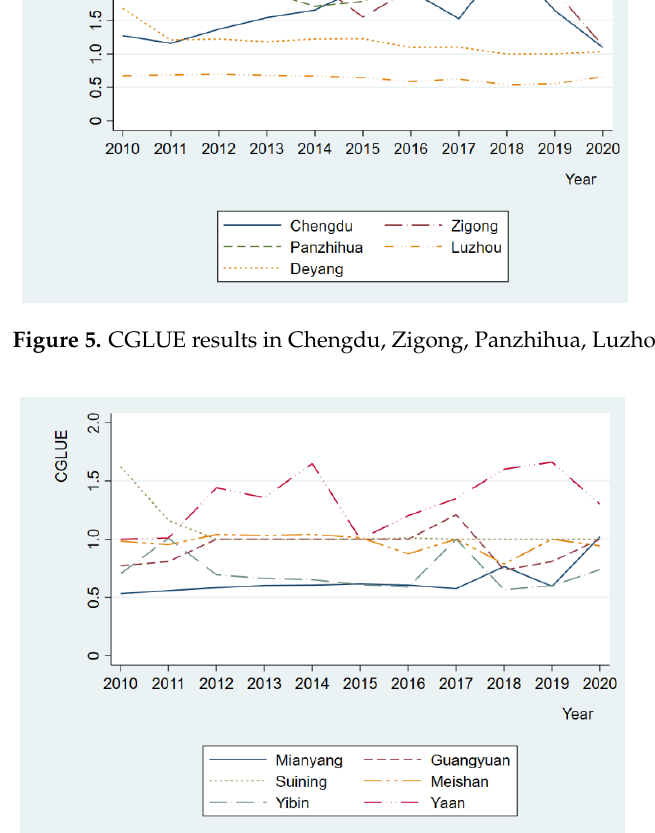
Figure 6. CGLUE results in Mianyang, Guangyuan, Suining, Meishan, Yibin, and Yaan.